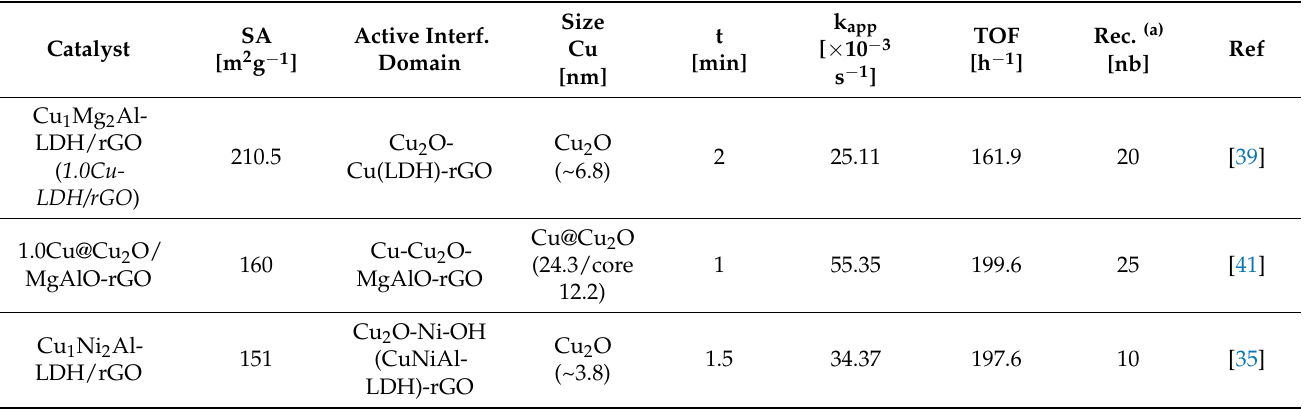
Table 5. Physico-chemical characteristics, catalytic performance in the reduction of 4-NP, and reusabil- ity of the nanocomposites containing Cu-based LDH and